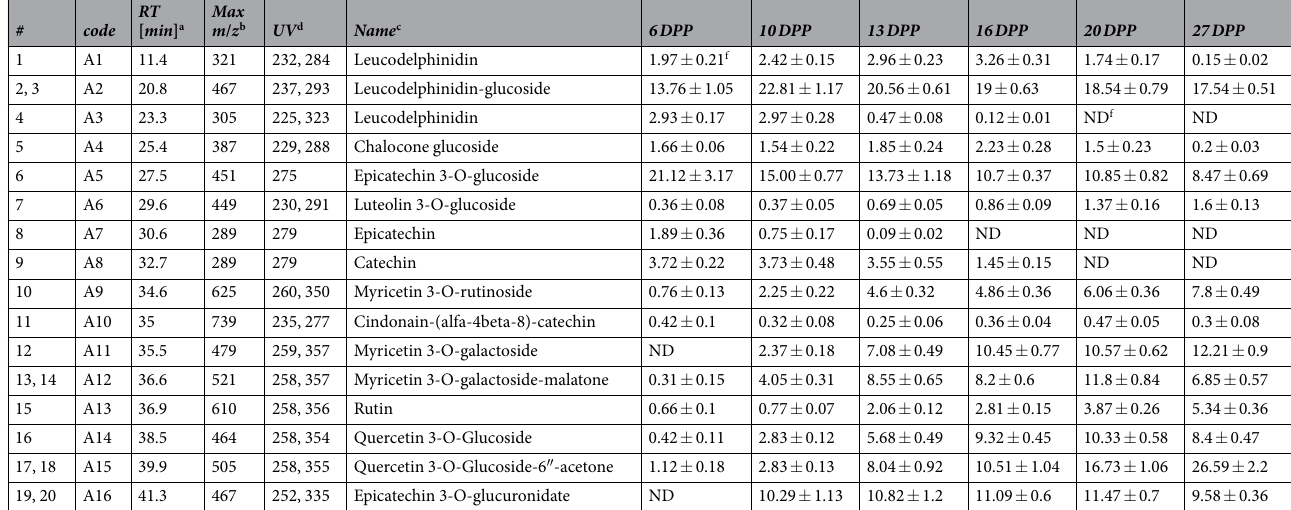
Table 1. Peak assignment for the analysis of extracts from seed coats at different development stages. a Measured with a C 18 Grace column and a corresponding gradient profile (see Materials and methods). b Obtained with an ion trap mass spectrometer. c Identified after comparison with standards and references. d Obtained with a UV